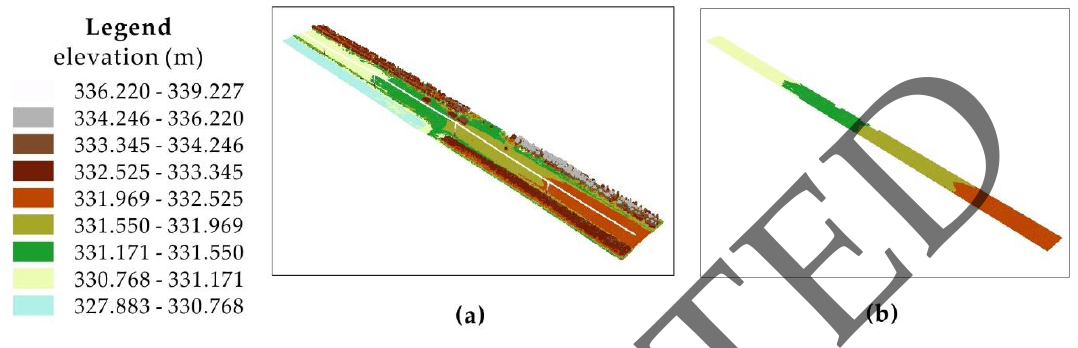
Figure 5. Point cloud filtering. (a) The original point cloud; and, (b) the pavement point cloud.